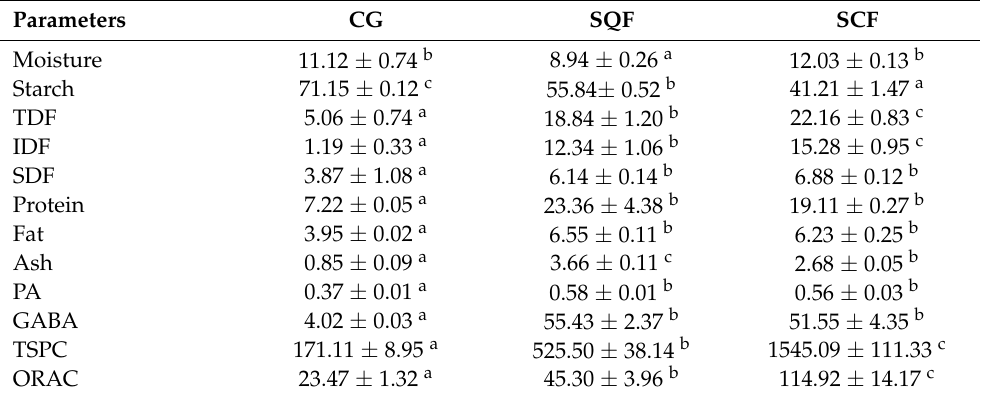
Table 2. Nutritional composition (expressed as g/100 g dry weight, dw), TSPC (mg GAE/100 g), GABA (mg/100 g) and antioxidant activity (expressed in µ mol TE/g) of raw materials. Parameters CG